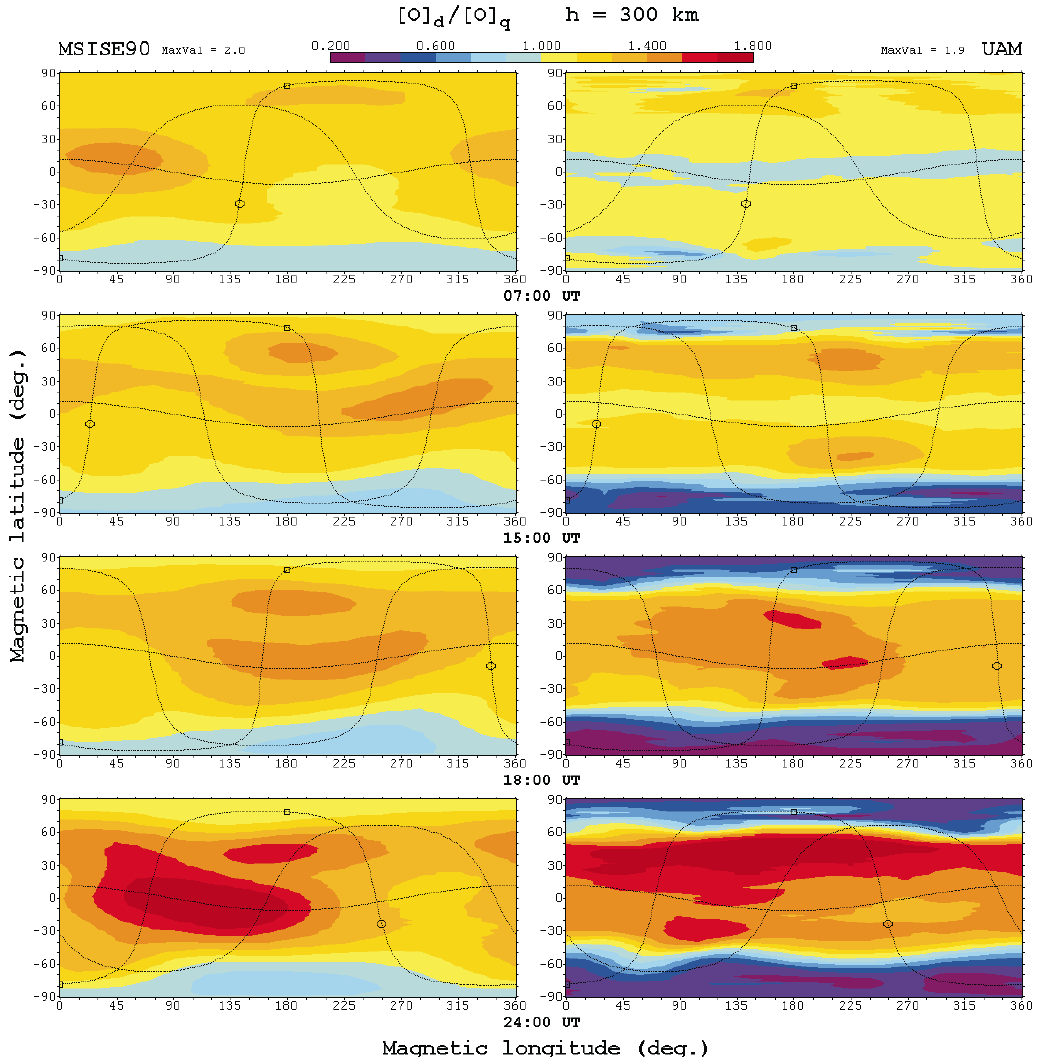
Fig. 2. The geomagnetic maps of the atomic oxygen concentration disturbance (storm to quiet concentration ratio R (O) = [O] [O] ) at height 300 km for 0700, 1500, 1800 and 2400 UT (from top quiet to bottom ) on 25.01.1974 calculated using the empirical thermospheric model MSISE90 ( left column) and calculated with the full theoretical Upper Atmosphere Model ( right ). The Sun position is shown by a